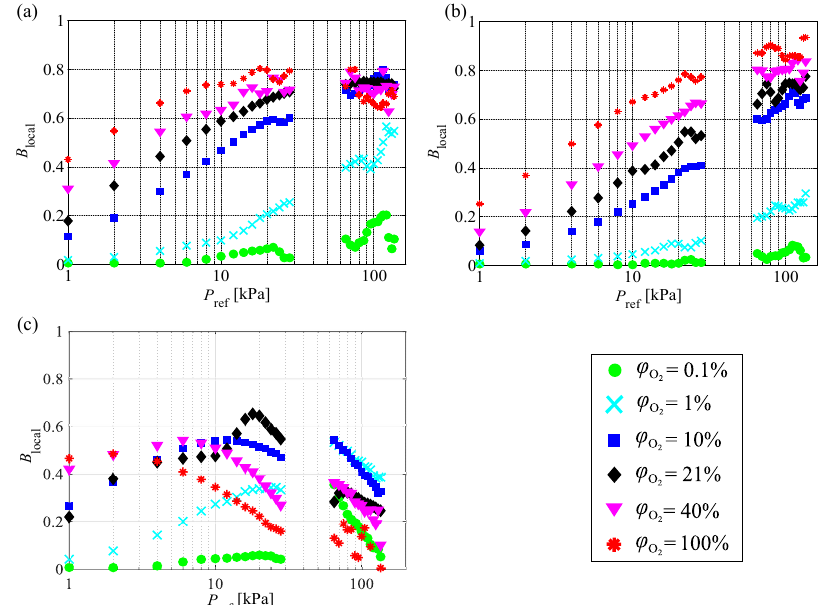
Figure 5. Effect of ambient pressure on B local at various oxygen mole fractions for ( a ) PHFIPM-PSP, ( b ) PC-PSP, and ( c )